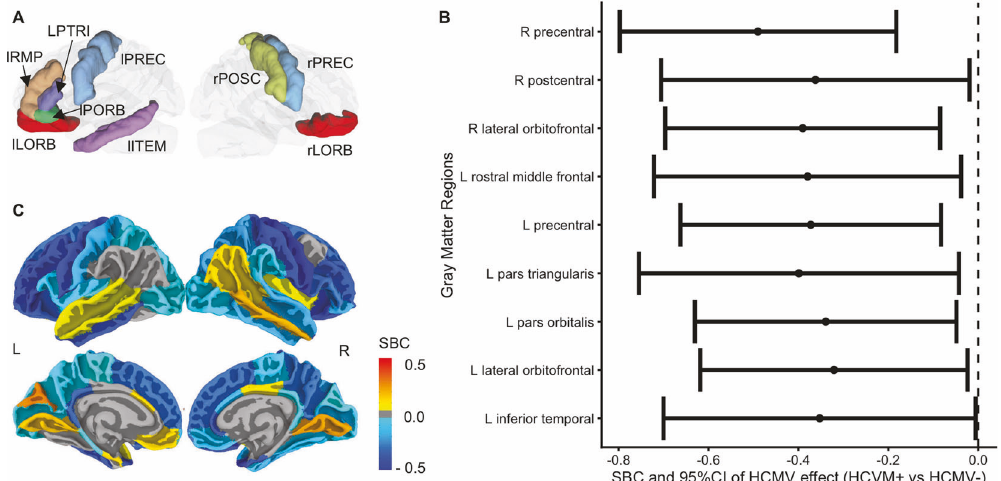
Fig. 1 Gray matter volume differences between HCMV + and HCMV − . A Illustration of regions that showed an effect of HCMV. Nine regions were signi fi cantly smaller in HCMV + versus HCMV − subjects at p uncorrected < 0.05. Two out of these nine regions (lPORB and rLORB) were also signi fi cantly decreased in the original study at p uncorrected < 0.05. B Standardized beta coef fi cient (equivalent to Cohen ’ s d) as effect size with 95% CI is estimated from the IPTW adjusted regression model. The robust standard error was used to calculate the 95%CI. C Mapping of the HCMV effect at all the cortical regions without thresholding (for exact values see Supplementary Table S1). Colors represent the standardized beta coef fi cients estimated from the IPTW adjusted regression model. They range from − 0.5 to 0.5, indicating that the mean gray matter volume of the HCMV + subgroup in the given region increased or decreased by 0.5 standard deviations relative to the HCMV − subgroup. Blue colors represent smaller gray matter volumes in HCMV + groups, whereas yellow-red colors represent larger gray matter volumes in HCMV + groups. Consistent with the original fi ndings, relative to HCMV − subjects, HCMV + subjects showed widespread smaller gray matter volumes, most prominently in orbitofrontal, temporal, and parietal regions. rLORB right lateral orbitofrontal gyrus, rPREC right precentral gyrus, rPOSC right postcentral gyrus, lLORB right lateral orbitofrontal gyrus, lPORB left pars orbitalis gyrus, lITEM left inferior temporal gyrus, lRMP left rostral middle frontal gyrus, LPTRI left pars triangularis, lOREC left precentral subjects (voxel-level p uncorrected < 0.001, cluster level p FDR < 0.05, Fig. 2B and Table 2). The strength of FC between the right anterior insula of the salience network and the left postcentral cluster was also signi fi cantly lower in the HCMV + group relative to the HCMV − group (cluster size = 274 voxels, SBC = − 0.91, [95%CI, − 1.28 to − 0.54]). Further, the strength of FC between the right sensorimotor cortex and the left frontal operculum cluster was signi fi cantly lower in the HCMV + group relative to the HCMV − group (cluster size = 405 voxels, SBC = − 0.99, [95%CI, − 1.36 to − 0.62]). No signi fi cant within-network differences were found between HCMV + and HCMV − when seeds were placed in the hub regions of default mode network, central executive network, and dorsal attention network. No signi fi cant network differences (between the ten prede fi ned network hub regions) were found between HCMV + and HCMV − using a threshold of p FDR < 0.05. Results signi fi cant at p uncorrected < 0.05 are reported in Supplementary Fig. S2 to show the putative inter-network connection alterations in association with HCMV serostatus. There was hypoconnectivity between sensor- imotor network, salience network, and dorsal attention network, and hyperconnectivity between default mode network and frontoparietal network observed when using a threshold of p uncorrected < 0.05 (Supplementary Fig. S2). The effect sizes of these connectivity differences were large. Correlations between HCMV IgG level, CRP, and neuroimaging fi ndings Correlation analyses were performed in the HCMV + subgroup for the nine cortical regions of reduced GMV, the fi ve pairs of ROI-to-ROI FC, and the two pairs of Seed-to-Voxel FC that showed signi fi cant alterations. Although no signi fi cant correlations survived FDR correction, CRP concentration was inversely correlated with the left pars orbitalis volume ( r = − 0.31, p uncorrected = 0.049) and the left pars triangularis volume ( r = − 0.32, p uncorrected = 0.044), as well as the FC between right postcentral gyrus and right inferior parietal gyrus ( r = − 0.35, p uncorrected = 0.03). There were no signi fi cant correlations